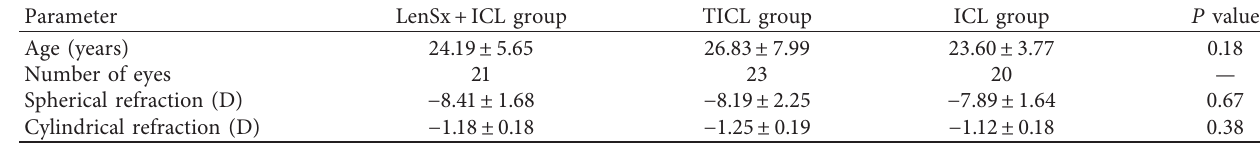
Table 1: Preoperative data of patients.